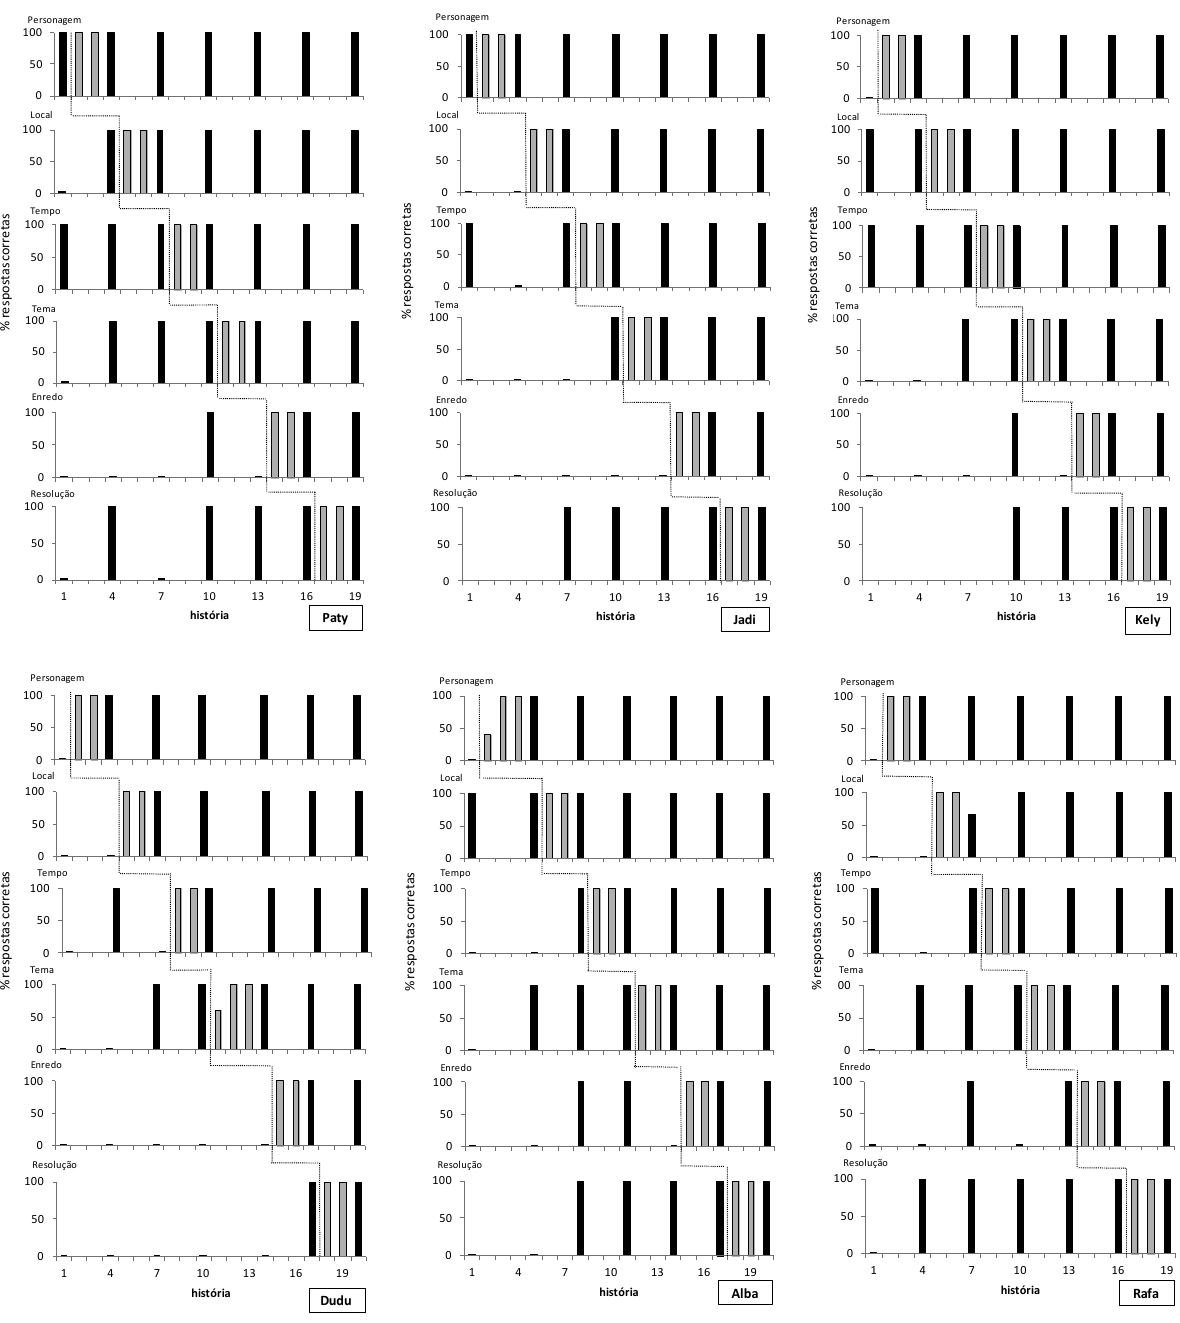
Figura 2. Porcentagens de Respostas Corretas por História, Durante o Ensino (Barras Cinzas) e nos Pré e Pós-Testes de Identi fi - cação (Barras Pretas) das Categorias Estruturais de História dos Participantes do Estudo